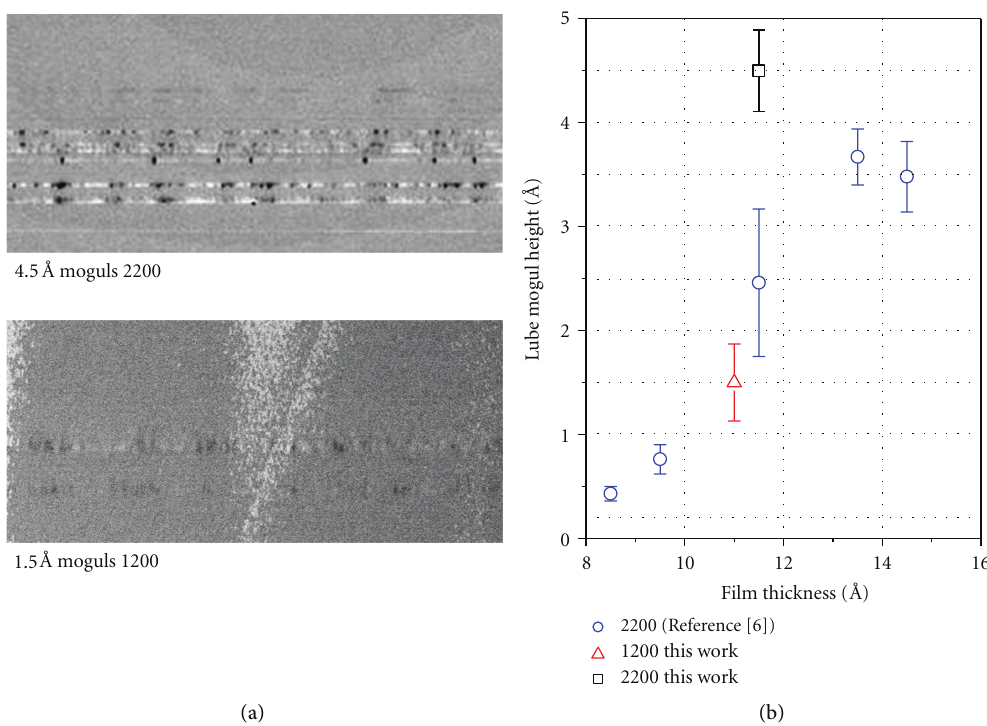
Figure 3: (a) Representative images of lube moguls after low flying on 11 . 5 ˚A Z-Tetraol 2200 (top) and 11 . 0 ˚A Z-Tetraol 1200 (bottom). These data were generated by flying the slider at 8nm above the disk surface with no pole tip protrusion. (b) Summary plot showing the lube mogul height as a function of Z-Tetraol 2200 film thickness (blue circles are taken from [6]).